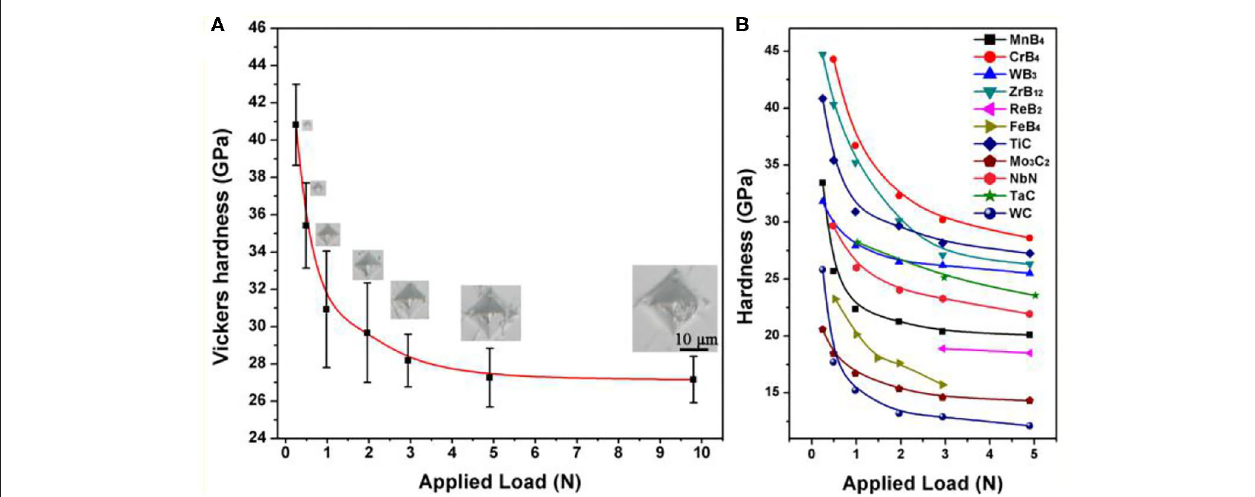
FIGURE 2 | (A) Vickers hardness value obtained as a function of the applied load of TiC 0.7 . The corresponding indentation images at different applied loads are presented above each data point. (B) Vickers hardness values of high boron concentration transition metal borides and titanium carbide.